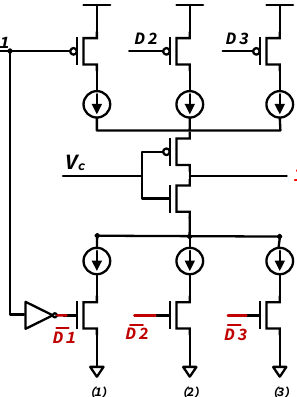
Figure 4. The structure of the current source for offset correction. D 1, D 2, D 3, , and are used to control three pairs of PMOS & NMOS transistors. When D 1 is low, the PMOS transistor is on. is generated from D 1, so is high. The corresponding NMOS transistor is on simultaneously. If D 1 is high, and is low, the left group of the PMOS and NMOS is off. When V and D 1 are low, the PMOS of the left group is on, i.e. , current c generated from upper current sources flows to line I . When V and are high, o c